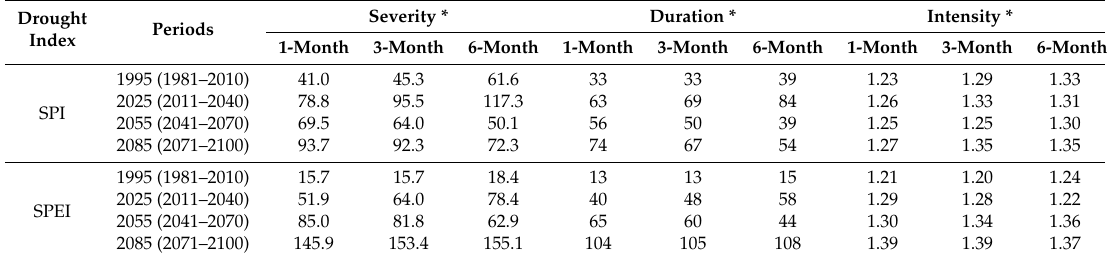
Table 5. Drought severity, duration, and intensity using the one, three, and six-month SPI and SPEI. Drought Index